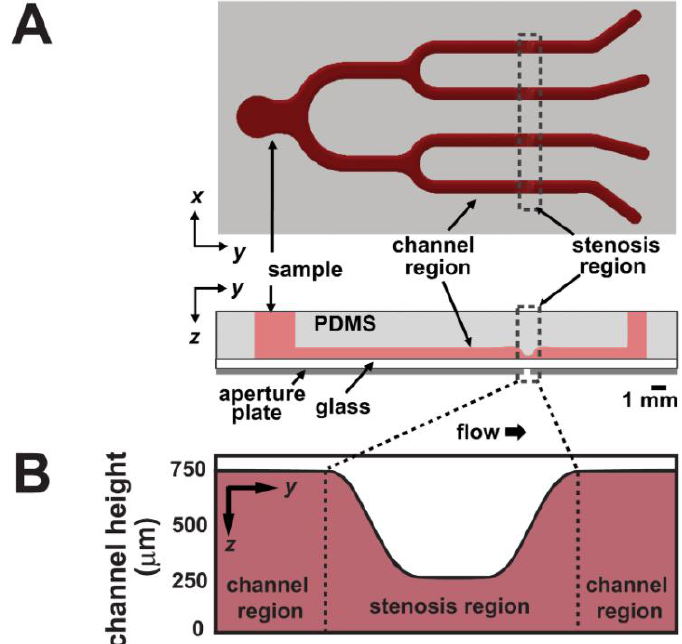
Figure 12. ( A ) schematic images of the microfluidic chip with four identical stenosis regions. ( B ) cross-section of the stenosis region. Adapted from Li et al. [22].